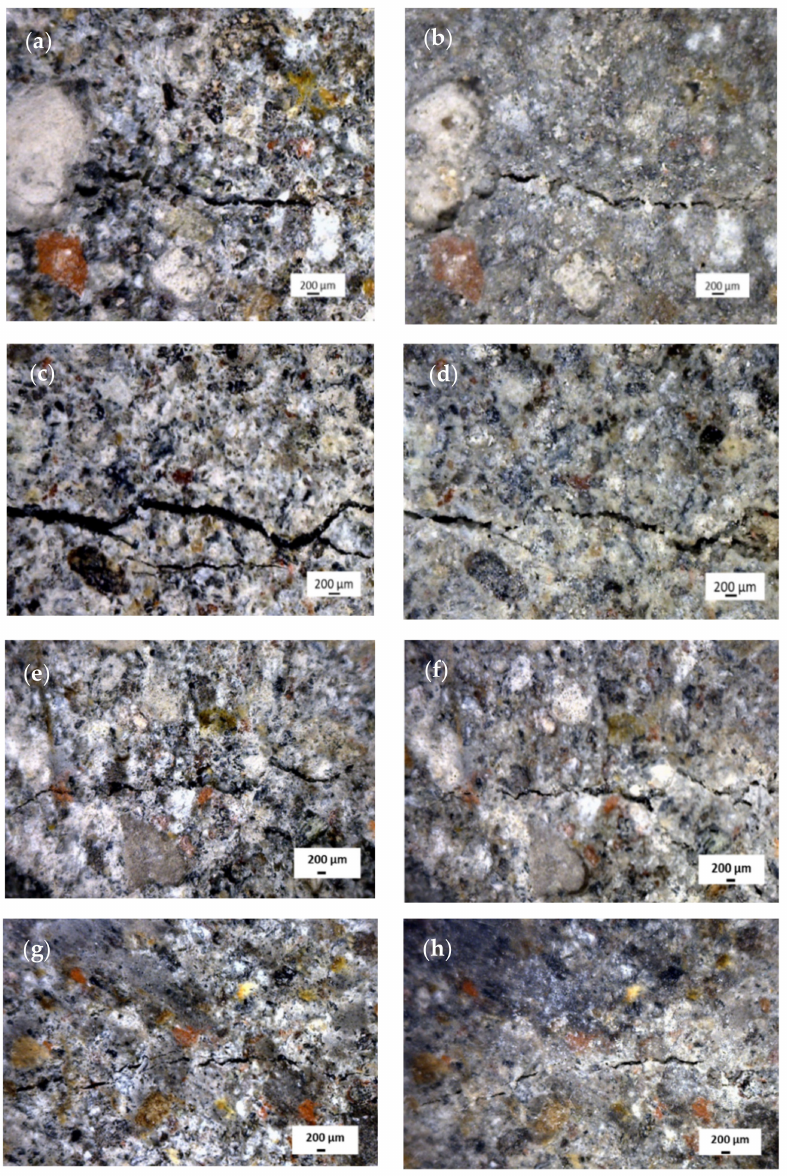
Figure 13. The crack recovery of mortar without OPEFB hydrochar fibre before ( a ) and after ( b ) 14 cycles, as well as with the addition of 1, 2, and 3% hydrochar before ( c , e , g ) and after ( d , f , h ) 14 cycles,